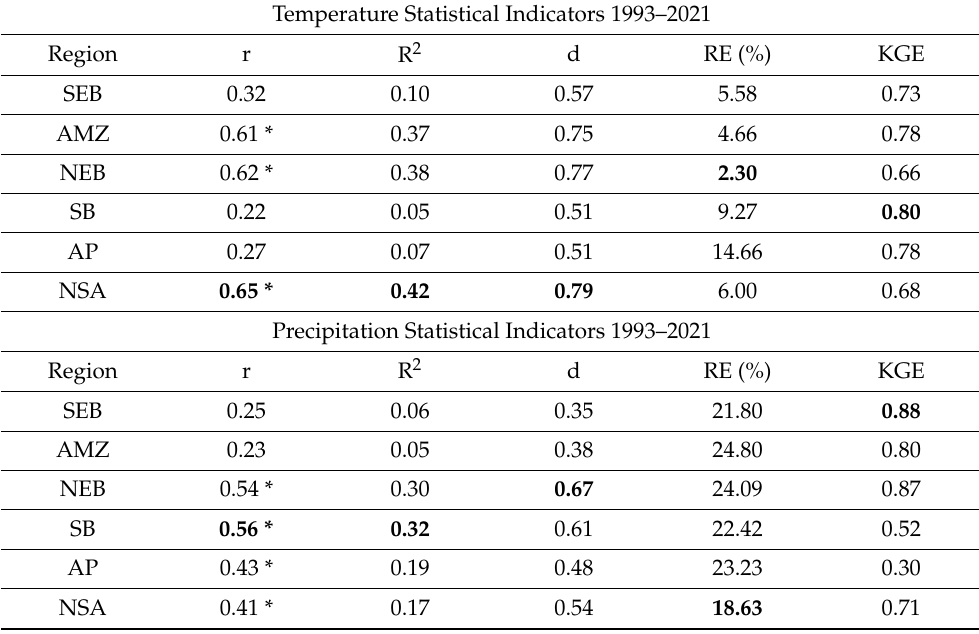
Table 1. Mean statistical indicators of temperature and precipitation anomaly predictions for each subdomain through the 1993–2021 period. For each indicator, the best results are in bold. Asterisks indicate statistically significant r values at a 95% significance level using Student’s t